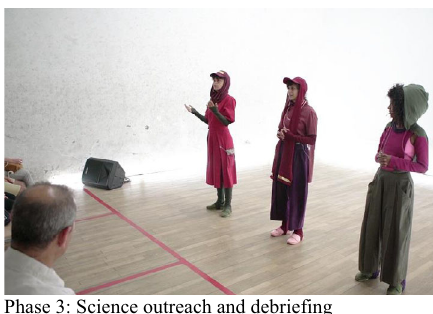
Fig.7|Theperformance-experimentphasesinStudy5. Theeventincludedfour main phases: (1) Introduction in which participants were randomly assigned to an experimental or a control condition; (2) Intergroup encounter in which partici- pants met separately with an Arab actor and with a Jewish actor, each of whom shared a sad personal story with them; (3) Debrie fi ng and science outreach in